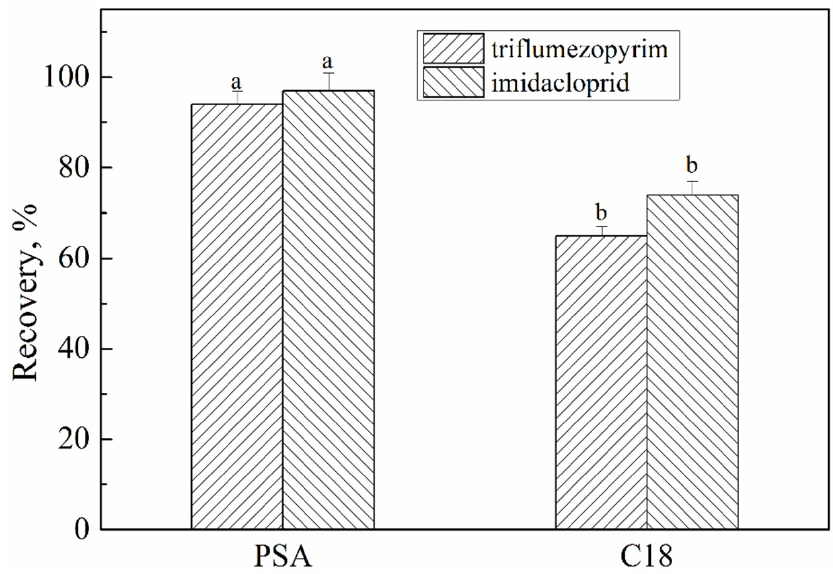
Figure 3. Effect of different purification sorbents on recovery. The letters (a and b) indicate a significant difference at the 1% level.